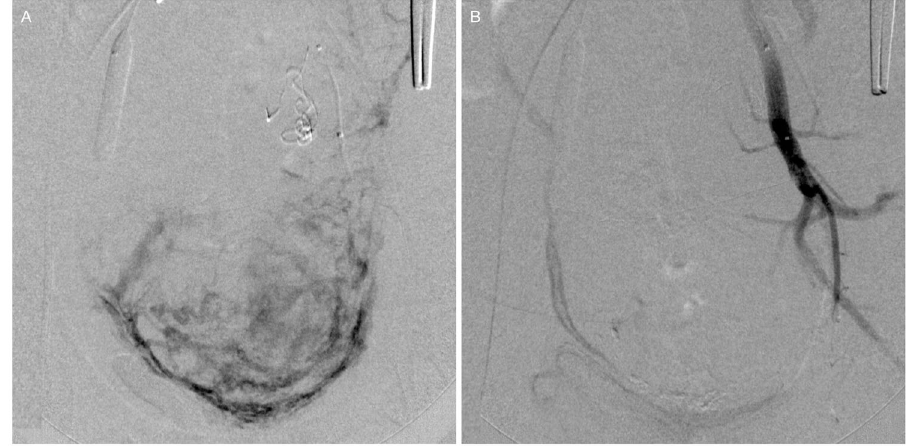
Figure 2 - (A) Angiographic images obtained before embolization depicting the enhancement of the uterine vessels. (B) Final angiographic results after embolization. Note the absence of enhancement in the uterine territory and the flow arrest at the left internal iliac artery branches.